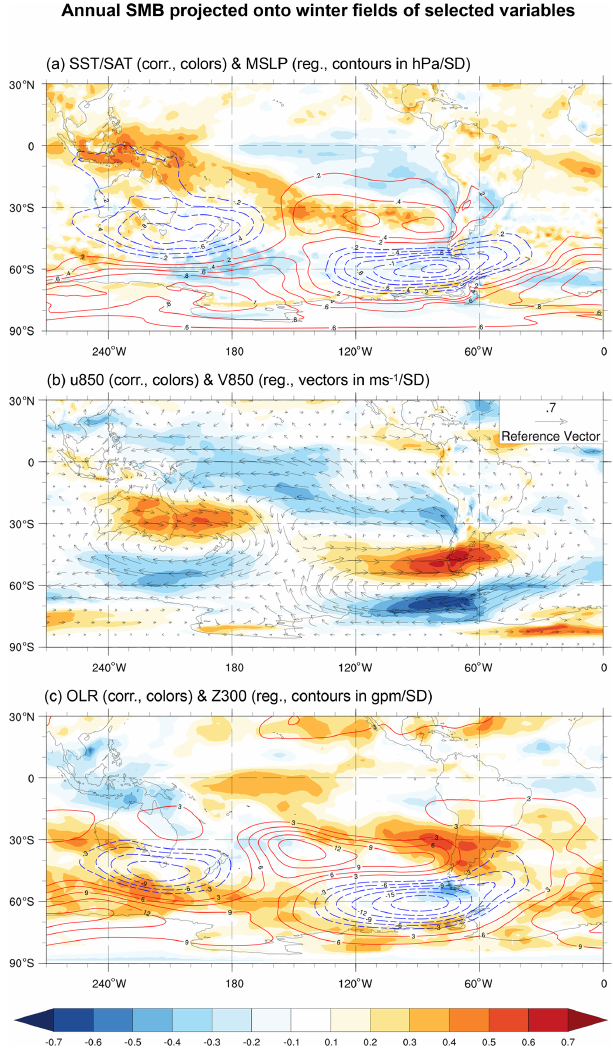
Figure 8. Large-scale correlation and linear regression maps of the annual (April to March) time series of the spatially averaged field of SMB with fields obtained from the Era-Interim reanalysis. (a) Re- gression with the annual field of mean sea level pressure (contours in hPa per SD) and correlation with the annual field of sea surface temperature (colors over ocean) and near-surface air temperature (colors over land). (b) Regression with the annual field of horizon- tal wind at 850hPa (vectors in ms − 1 per SD) and correlation with the annual field of zonal wind at 850hPa (colors). (c) Regression with the annual field of geopotential height at 300hPa (contours in gpm per SD) and correlation with the annual field of outgoing long- wave radiation (colors).